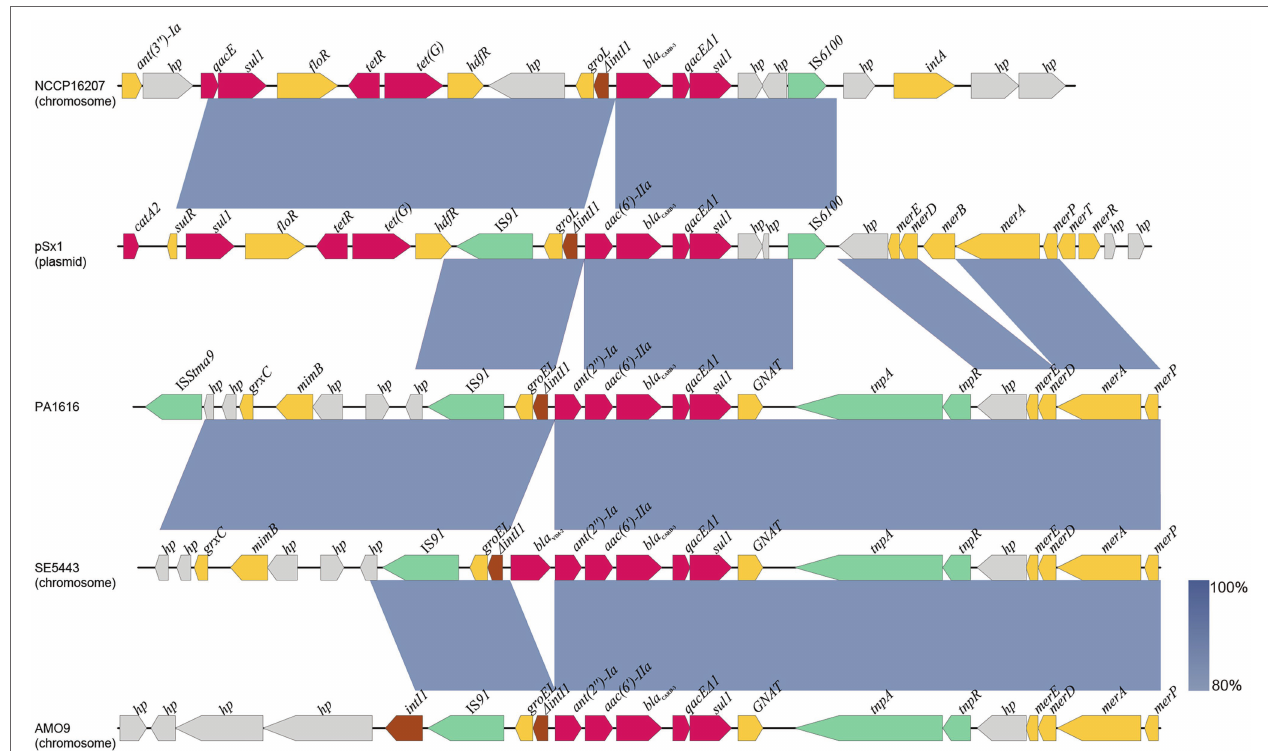
FIGURE 5 | Comparative analysis of the bla CARB-3 of PA1616 encoding region with other sequences from different bacteria: Achromobacter xylosoxidans AMO9 (JX448550.1), P. aeruginosa SE5443 (CP046405.1), Salmonella enterica NCCP16207 (CP041976.1), and Shewanella xiamenensis plasmid pSx1 (CP013115.1).